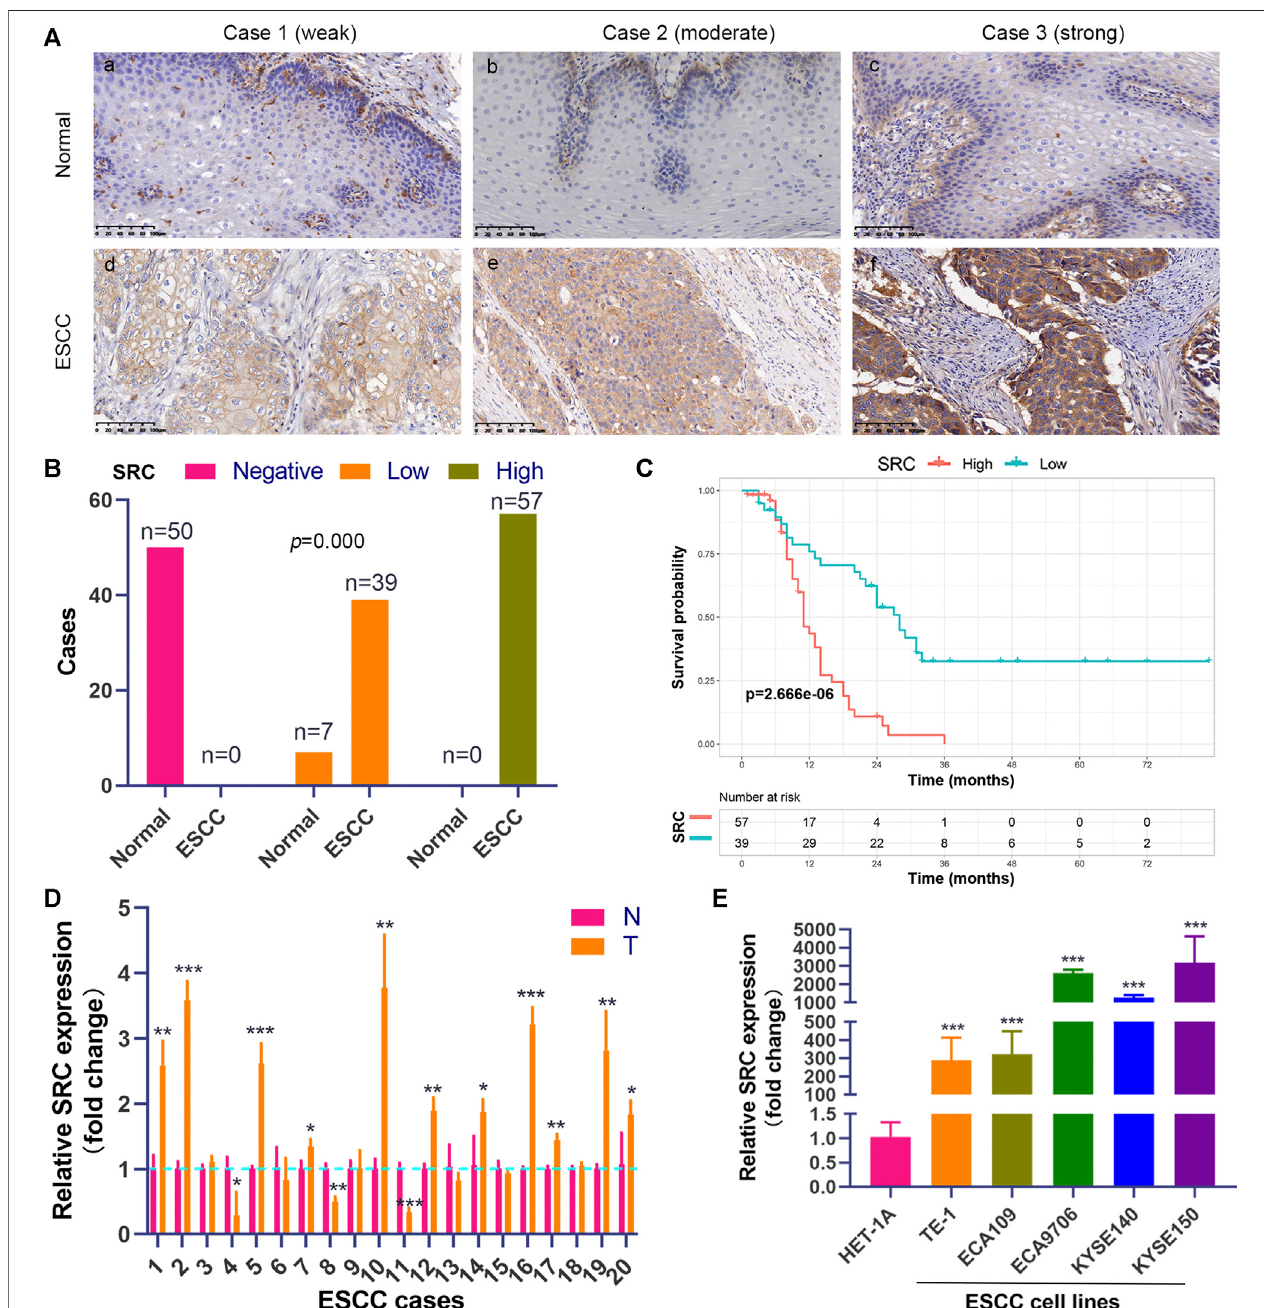
FIGURE 10 | SRC expression is elevated and correlated with poor prognosis in ESCC. (A) Comparison of SRC immunostaining in ESCC and normal esophageal squamousepithelium(magni fi cation, × 200). (i,ii,iii) NegativeexpressionofSRCincytoplasmofcellsinnormalesophagealsquamousepithelium. (iv,v,vi) Representative ESCC casesshowingweaktostrongcytoplasmicSRCstaining. (B) ThehistogramshowsthestatisticsofSRCimmunostaining inESCC andnormalesophageal tissue. Wilcoxon rank sum test, p (cid:1) 0.000. (C) Kaplan-Meier curves according to SRC expression status in ESCC. log-rank test, p (cid:1) 2.666e-6. (D) The relative mRNA expression levels of SRC in ESCC tissues and paired normal esophageal epithelial tissues. (E) Comparison of SRC expression in ESCC cell lines and esophageal epithelial cell line (HET-1A) using qRT-PCR. * p < 0.05, ** p < 0.01, *** p < 0.001.